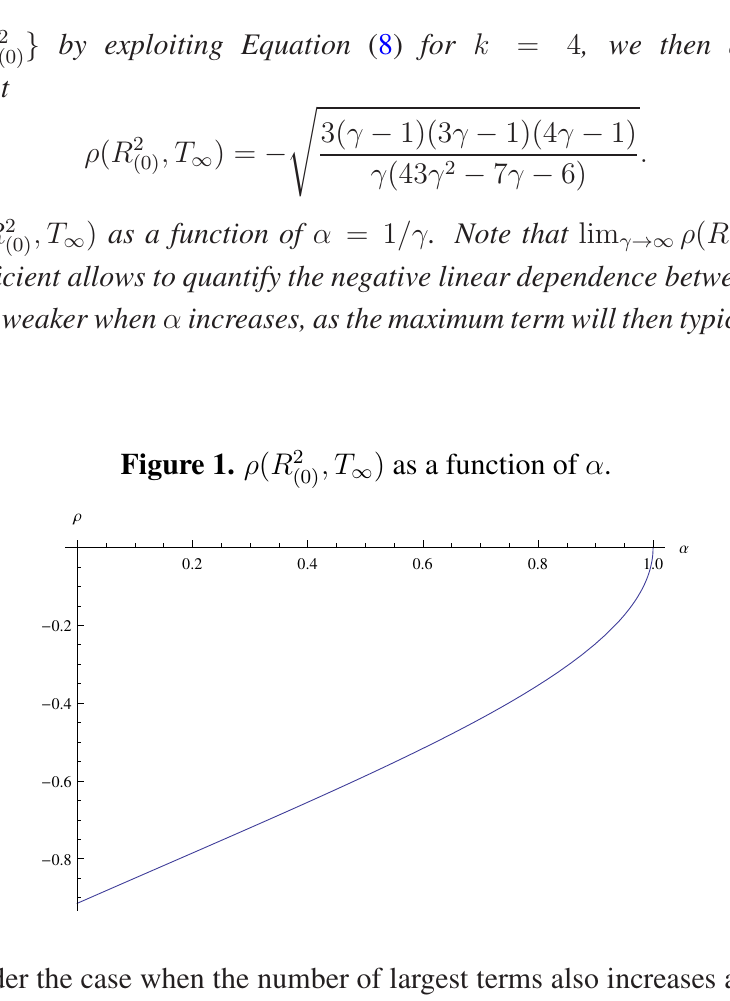
, T ) as a function of α ∞ (0)